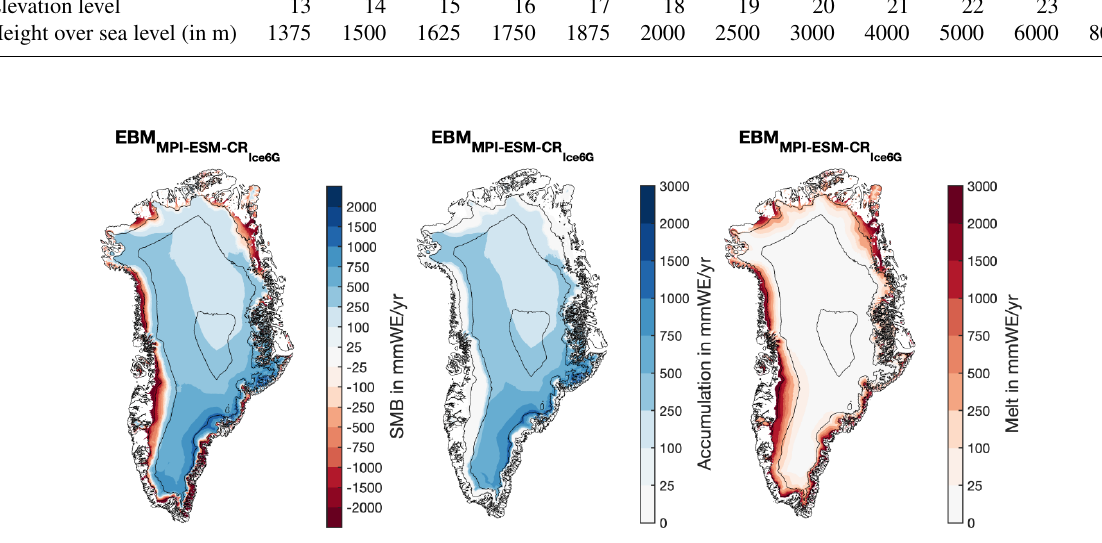
Figure A1. Similar to Fig. 1 but for the MPI-ESM-CR Ice6G